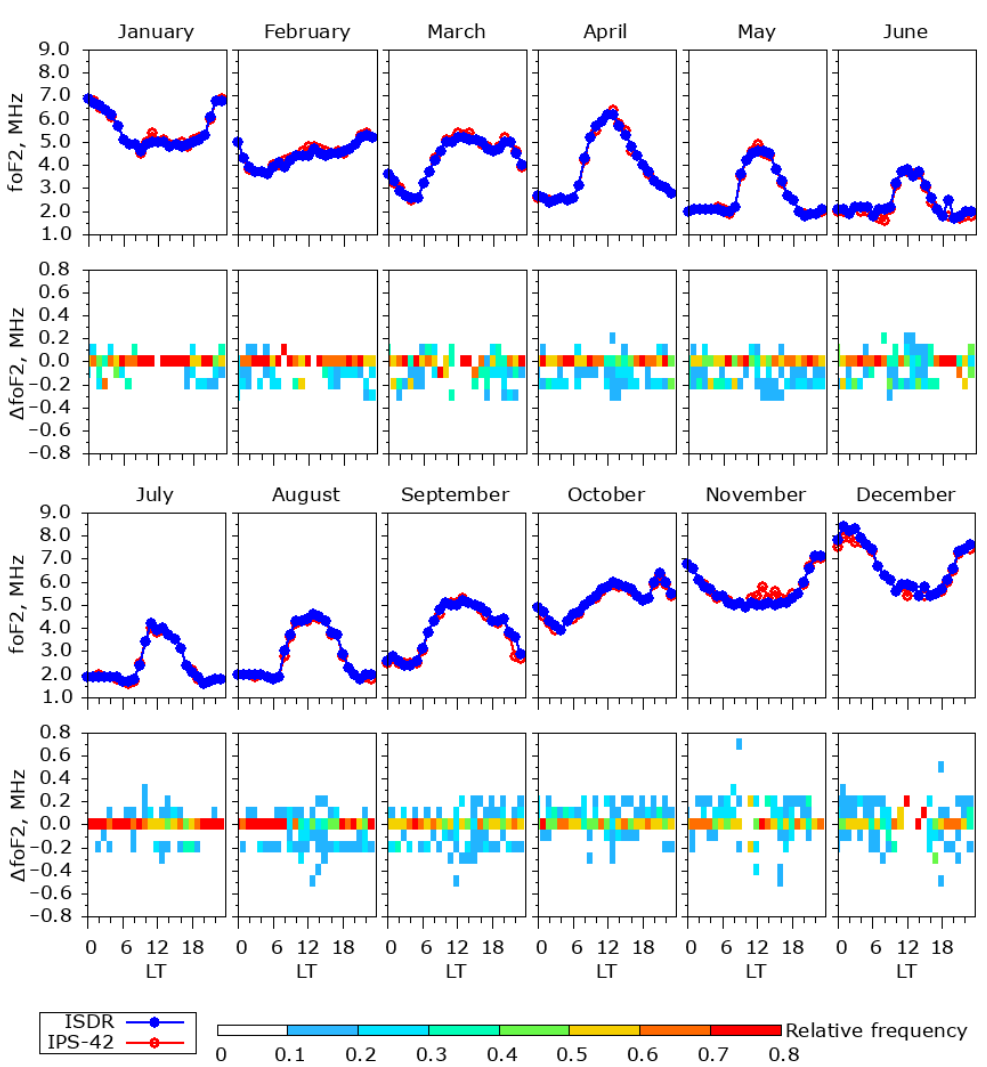
Figure 10. Median values of the critical frequency foF2 (ISDR data—blue lines, IPS-42 data—red lines) and the distribution of diurnal differences in the critical frequency ∆ foF2 for all months of the year 2021.